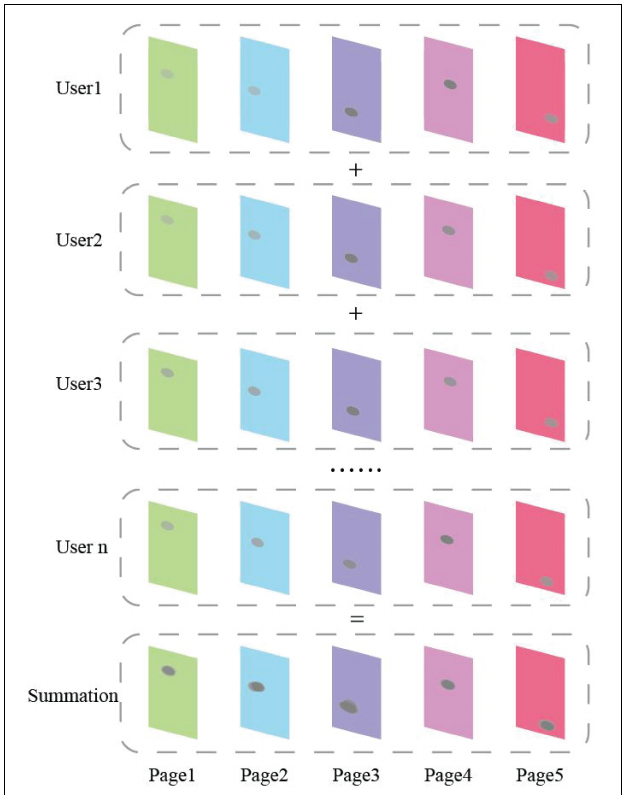
FIGURE 6 | An example of the proposed projection method.